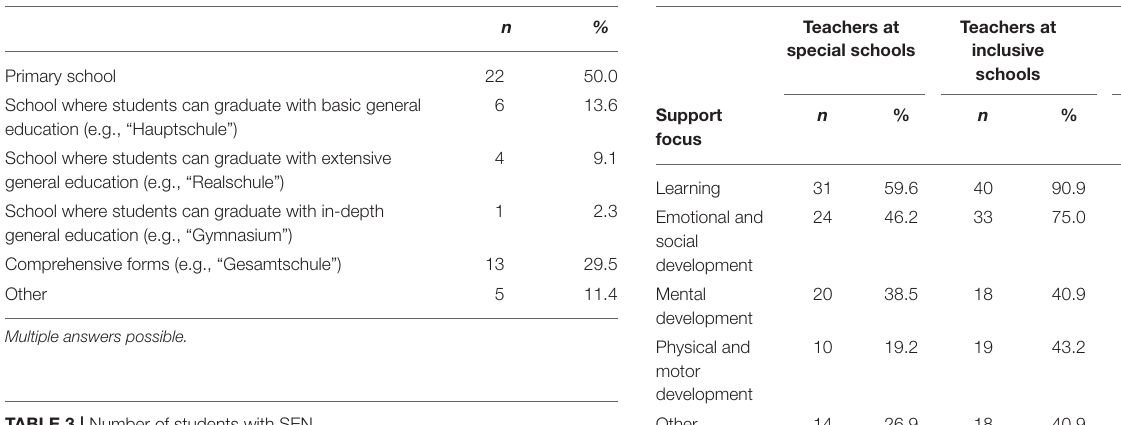
TABLE 2 | School forms of the inclusive schools teachers work at.